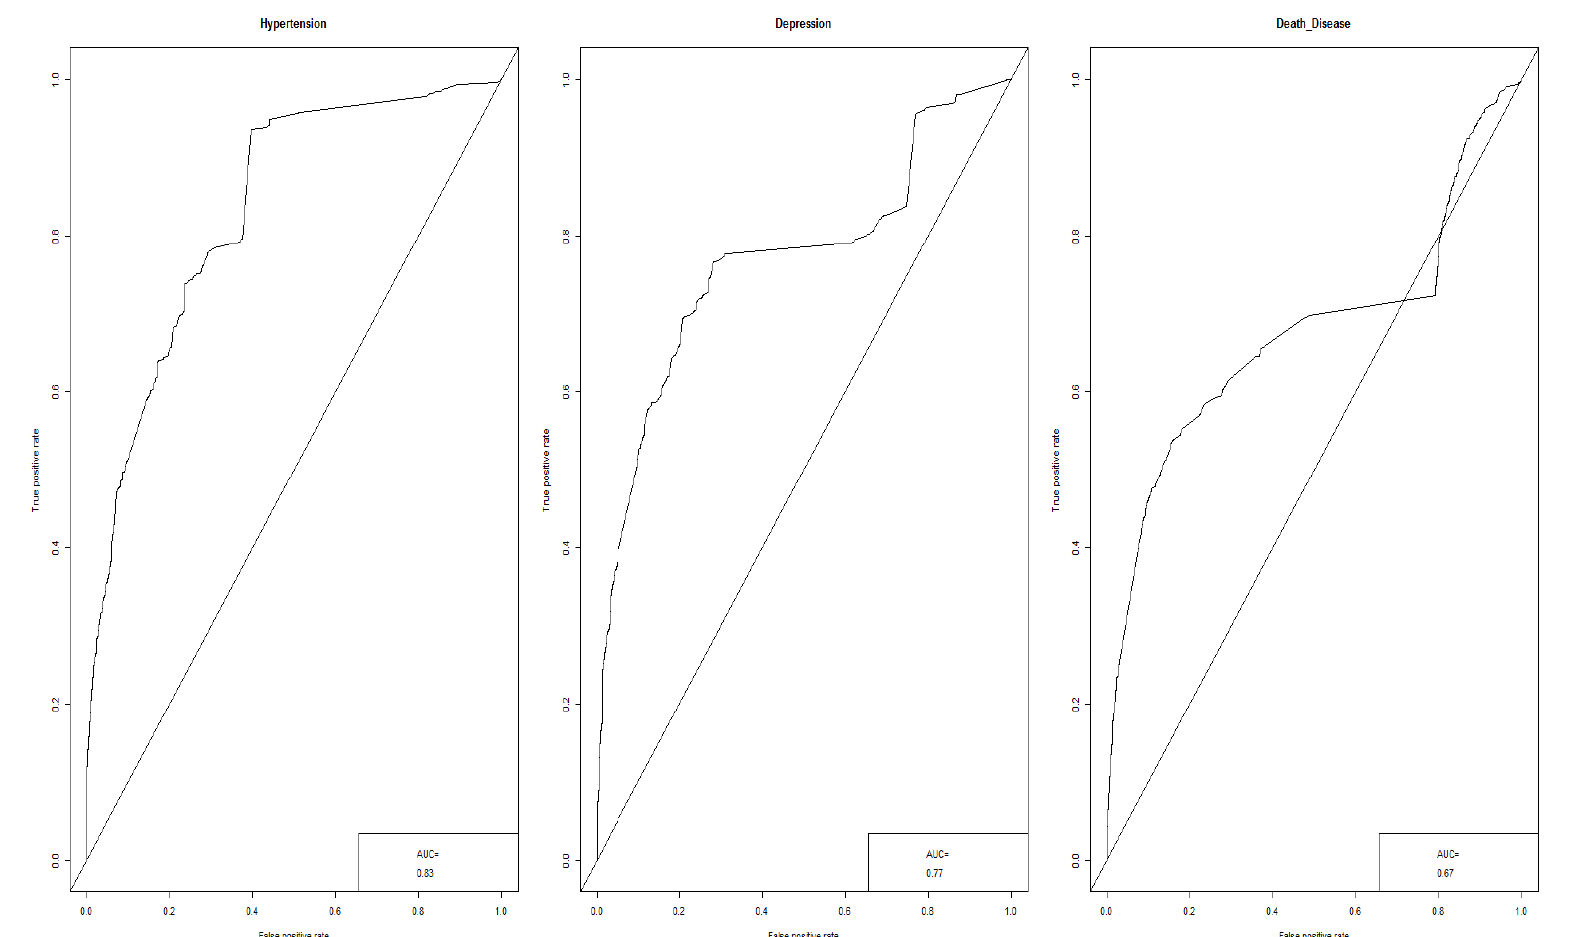
Figure 6. Performance of Machine Learning for Predicting Disease Causes of Particulate Matter.